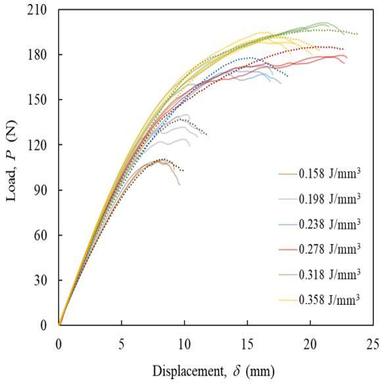
Experimental and numerical P-δ curves of SLS test specimens depending on EDV. Dotted-line refers to numerical data.